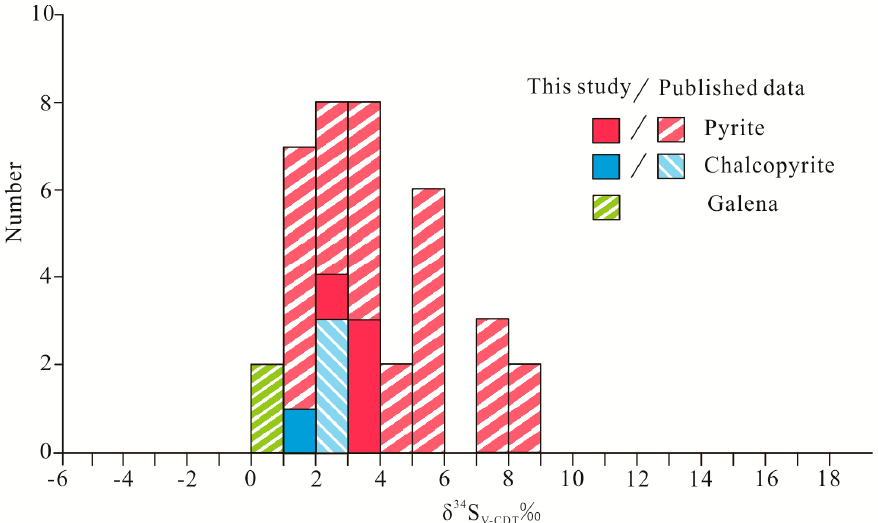
Figure 11. Histogram of S isotopic compositions for the Jinchang deposit and existing S isotopic data from Jia et al. [9], Mu et al. [14], and Li et al. [40].